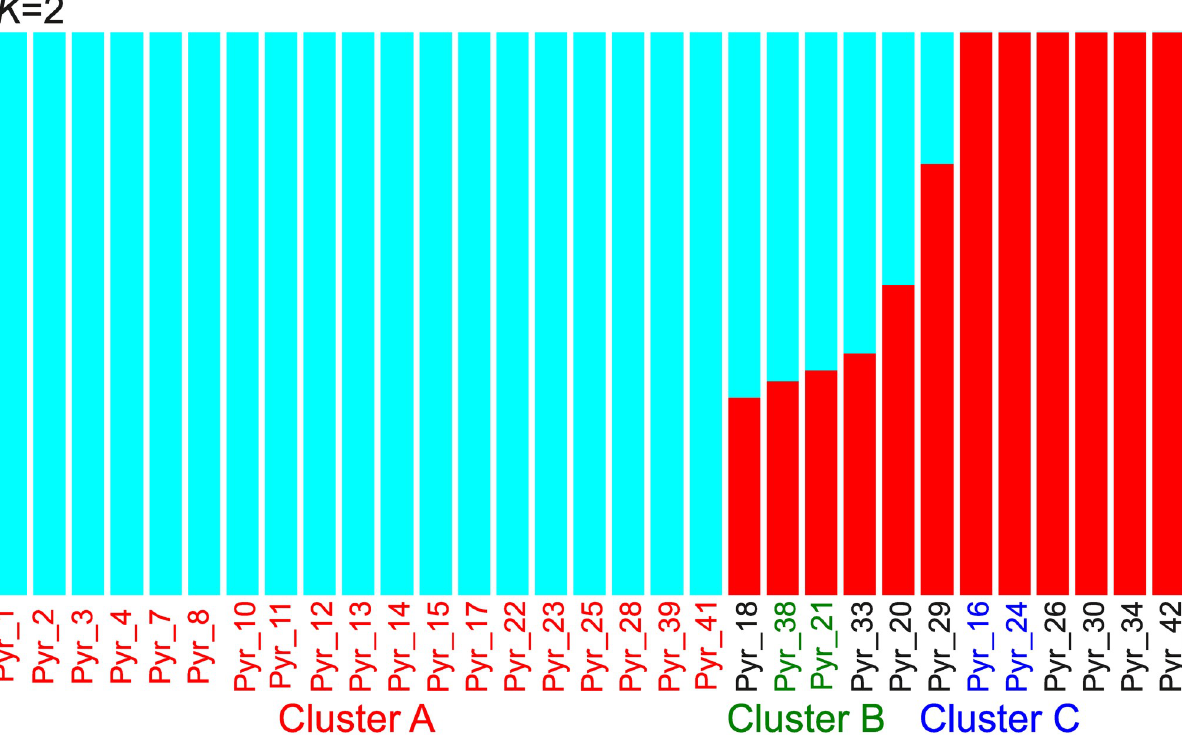
Fig 6. Admixture analysis using nuclear DNA data of 31 Pyropia yezoensis samples. The number of populations (K) was set to 2. Colors of the sample names were used to show 3 clusters, cluster A, B, and C.